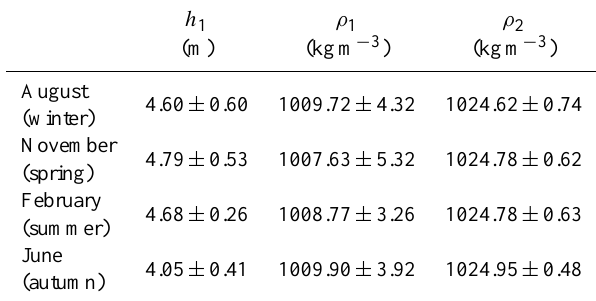
Table 2. Seasonal statistics of the mean depth of the upper layer and the densities of the upper and deep